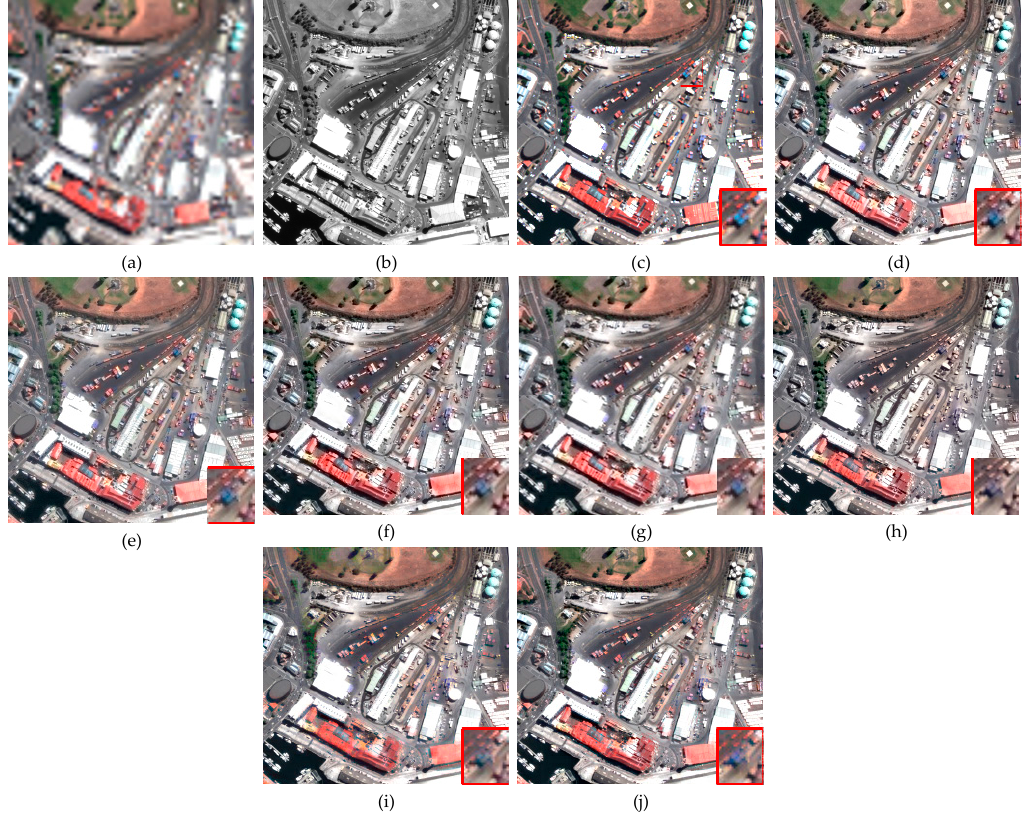
Figure 10. Fusion results of reduced-scale Geoeye-1 images. ( a ) LR MS image, ( b ) PAN image, ( c ) reference image, ( d ) GIHS [49], ( e ) PCA [6], ( f ) AWLP [50], ( g ) SVT [12], ( h ) SparseFI [32], ( i ) NE, ( j ) SWNE. Table 2. Numerical results of each fused image shown in Figure 10.